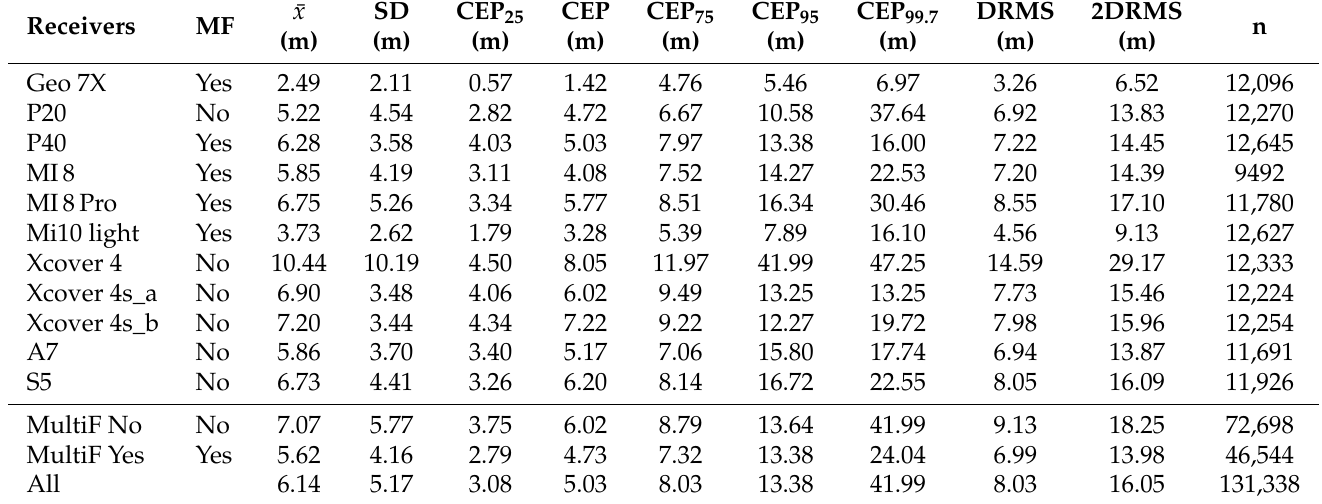
Table 4. Characteristic values of the absolute two-dimensional position deviation of the differ- ent smartphones and GNSS receivers used in the empirical experiments. (MF: multi-frequency; ¯ x : arithmetic mean; SD: standard deviation; CEP xx : circular error probable of xx%; CEP: circular error probable of 50%; DRMS: distance root mean square; 2DRMS: twice distance root mean square, n: number of